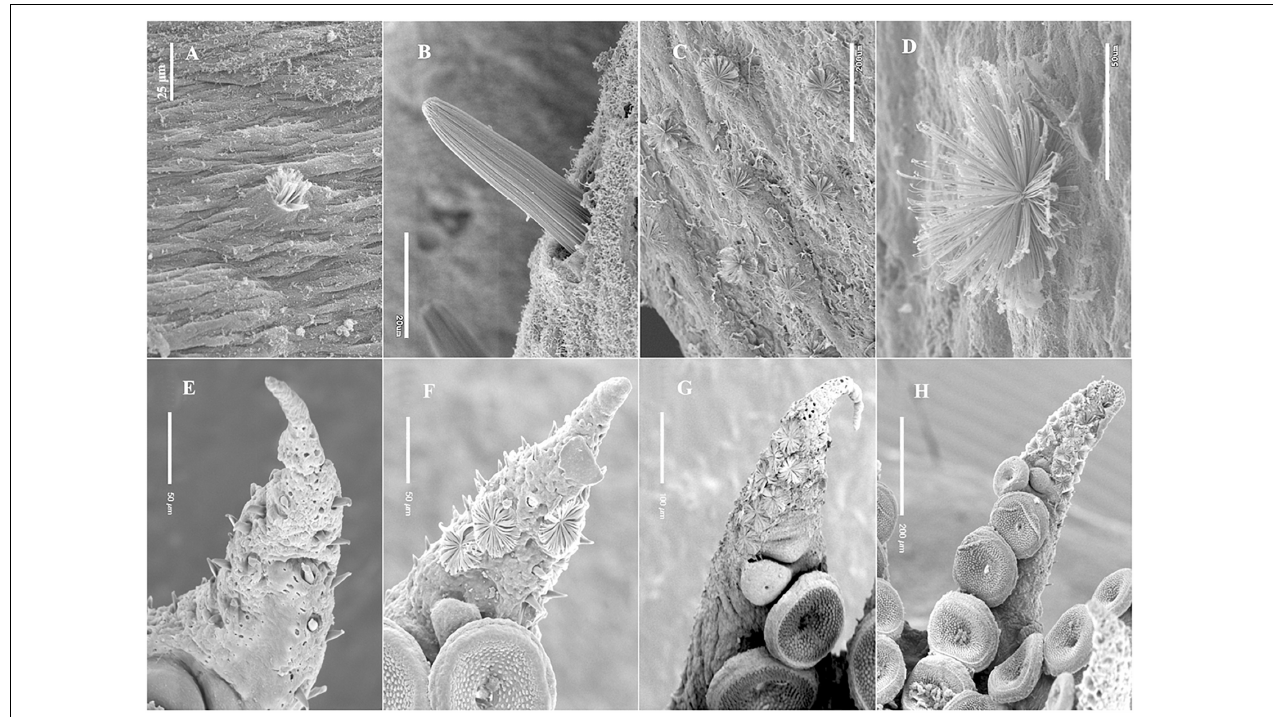
FIGURE 3 | Kölliker’s organs (KO) eruption and eversion sequence, SEM images. (A) Initially erupted KO on the dorsal mantle, Amphioctopus fangsiao , aged 5 days, (ML 3.2 mm); (B) , erupted KO on the dorsal surface of right arm II, Enteroctopus megalocyathus , 5.3 mm ML, aged 0 day; (C) , several fully everted KO, ventral mantle, Octopus vulgaris , wild benthic individual 7.8 mm ML; (D) , detail of fully everted KO on dorsal mantle of the same individual as in (C) . (E–H) Amphioctopus aegina, arm tips with KO on the arm oral side. Note that setae from contiguous KO can be in contact when fully everted. (E) KO erupted (none everted) on right arm IV from an individual aged 0 day; (F) , KO erupted and everted on right, arm II, from an individual aged 7 days; (G) , most KO everted on right arm II of an individual aged 2 days; (H) , most KO everted on right arm I of an individual aged 3